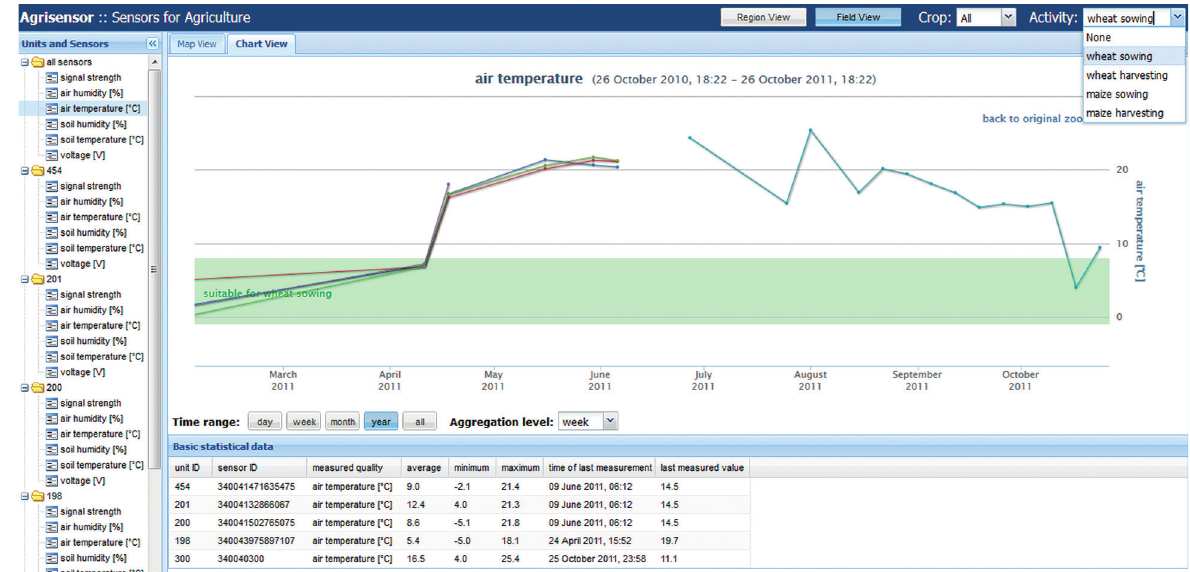
Fig. 6. Temporal visualization presenting values from all sensors that measured air temperature in the time period March– October 2011. The range of values suitable for the selected context (wheat sowing) is indicated by a coloured